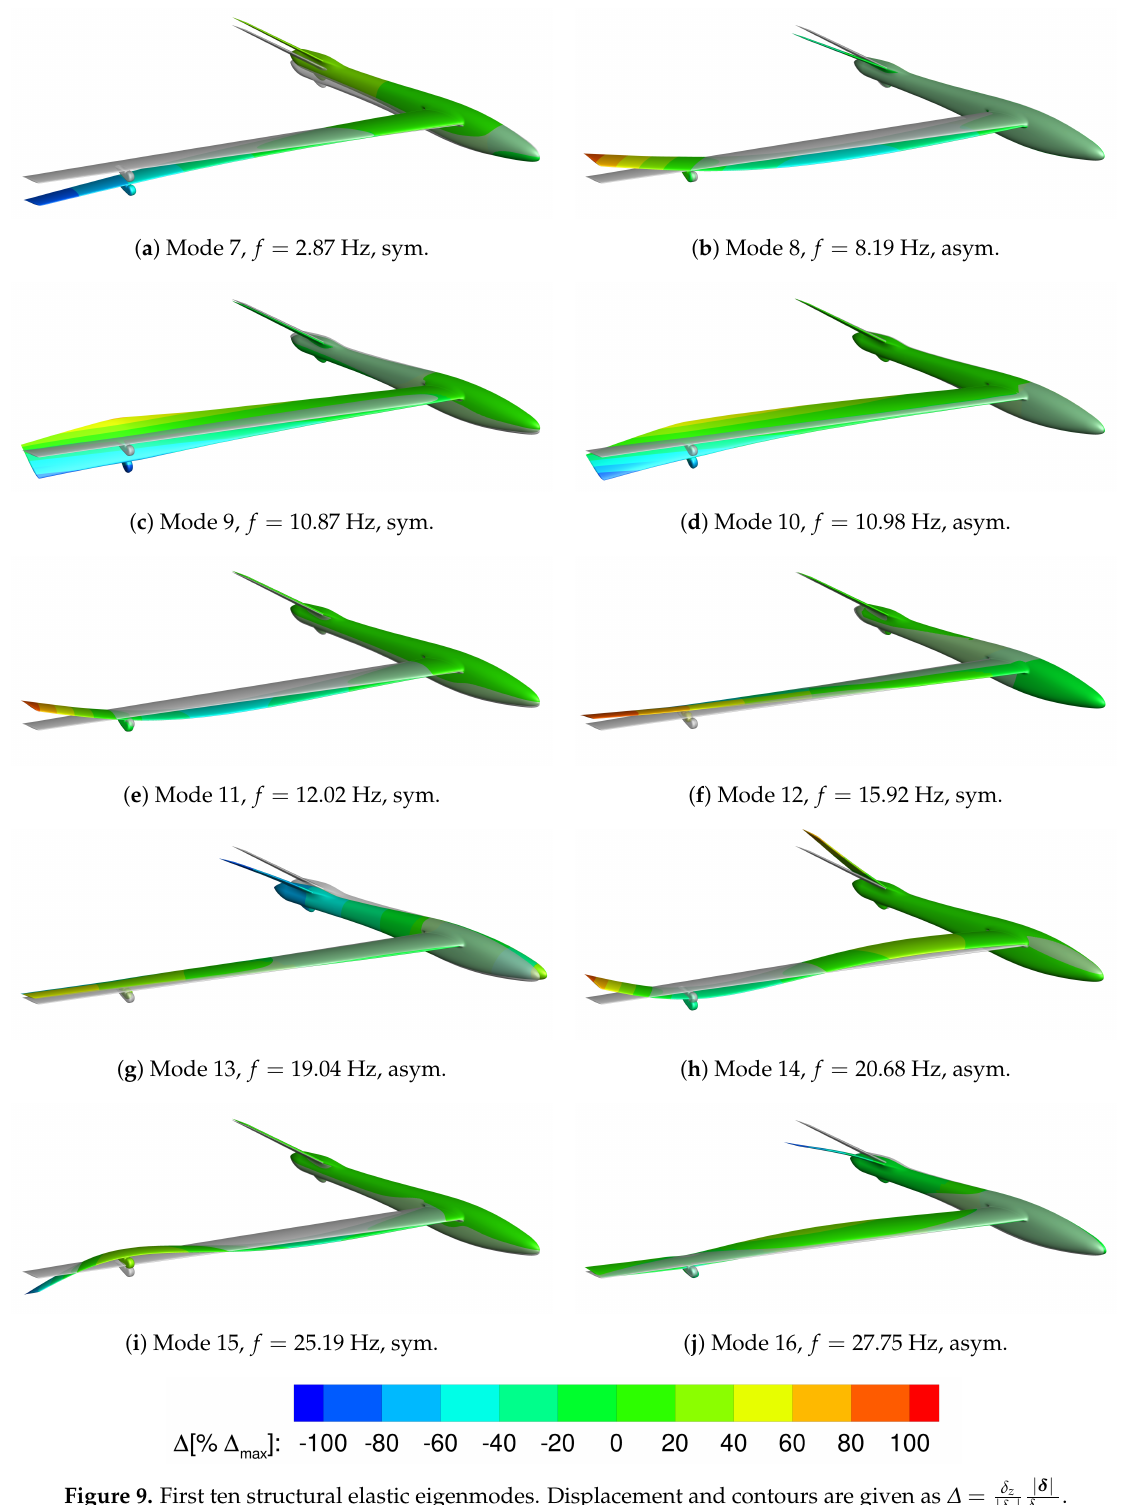
Figure 9. First ten structural elastic eigenmodes. Displacement and contours are given as ∆ = δ z Labels “sym” and “asym” denote symmetric and antisymmetric modes,